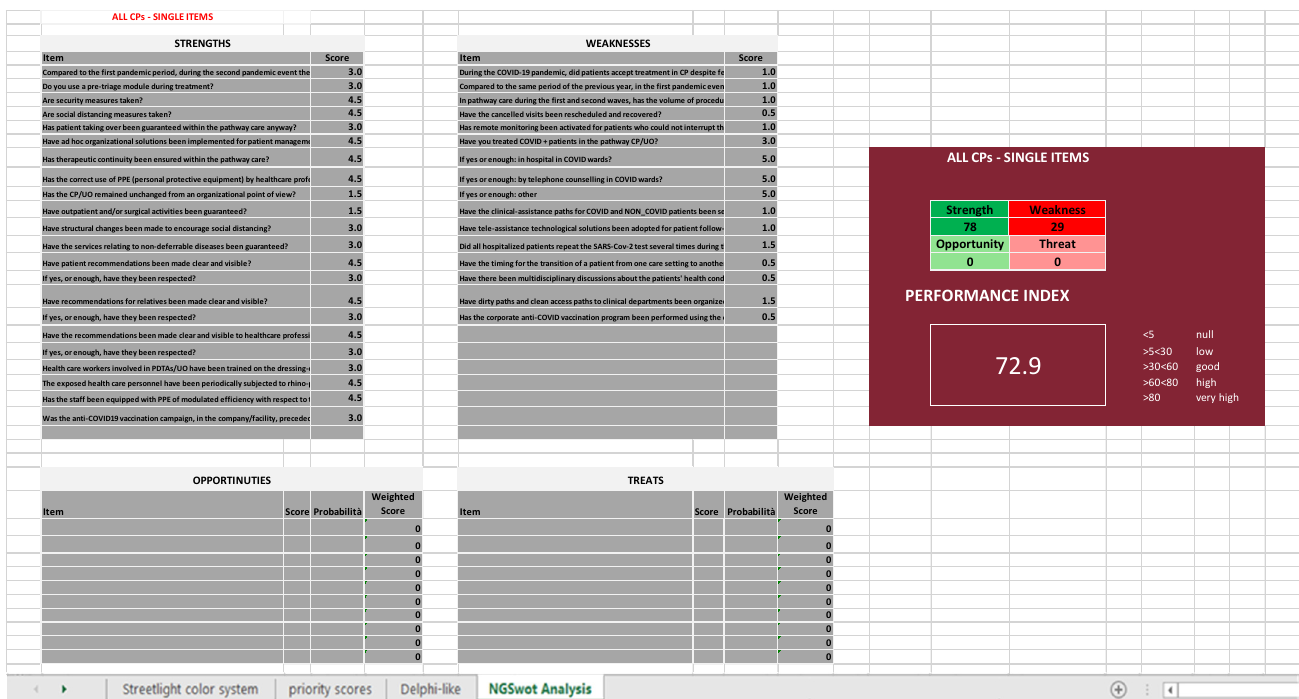
depth of analysis (Figure 5B). However, seeing that there are not subjective items, the last two tables have not been filled; therefore, the NGSA sheets all appear similar to the one shown in Figure 8.